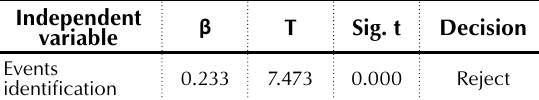
Table 4. Results of a simple linear regression analysis to test the third sub-hypothesis ( H03